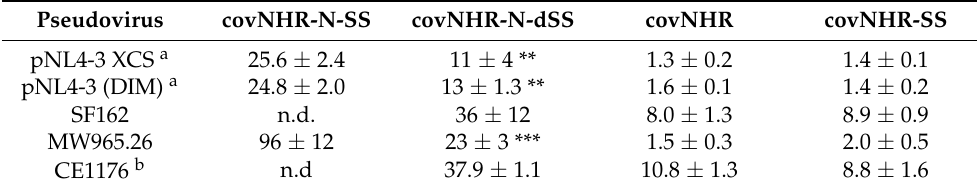
Figure 6. HIV-1 inhibitory activity of the miniproteins implemented in this study on different HIV-1 strains. In vitro inhibition of different HIV-1 strains infection of TZM-bL cells by fusion inhibitors, covNHR (black), covNHR-SS (blue), covNHR-N-SS (red) and covNHR-N-dSS (green), added at different concentrations. The different HIV-1 strains are ( A ) pNL4-3 XCS (pseudovirus designed for resistance to T20); ( B ) pNL4-3 (DIM) (pseudovirus designed for resistance to T20); ( C ) SF162 (pseudovirus strain); ( D ) MW965.26 (pseudovirus strain) and ( E ) CE1176 (primary isolate). Data are the mean ± S.D. of three independent measurements. Continuous lines correspond to non-linear regression curves using a sigmoidal Hill function as implemented in Origin software (Originlab, Northampton, MA, USA). Table 2. In vitro HIV-1 inhibition by covNHR